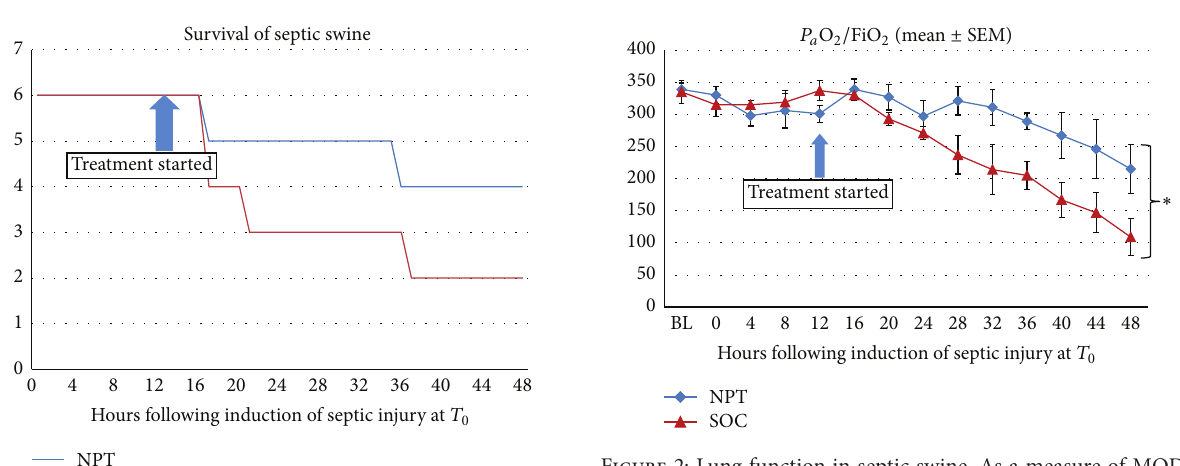
Figure 2: Lung function in septic swine. As a measure of MODS, lung function was determined by calculating the partial pressure of arterial oxygen divided by the fraction of inspired oxygen ( 𝑃 𝑎 O 2 /FiO 2 ) at various intervals following the induction of septic injury. Lung function was severely compromised in the SOC group at 24 hrs following induction of septic injury as seen by a continual drop in 𝑃 𝑎 O 2 /FiO 2 from baseline (BL). However, NPT initiated at 12 hrs after injury not only appeared to reduce the severity of lung injury as seen by a delayed drop in 𝑃 𝑎 O 2 /FiO 2 but also resulted in significantly better lung function over approximately the last 20 hrs of the experimental period compared to the SOC group ( ∗ 𝑝 = 0.0015